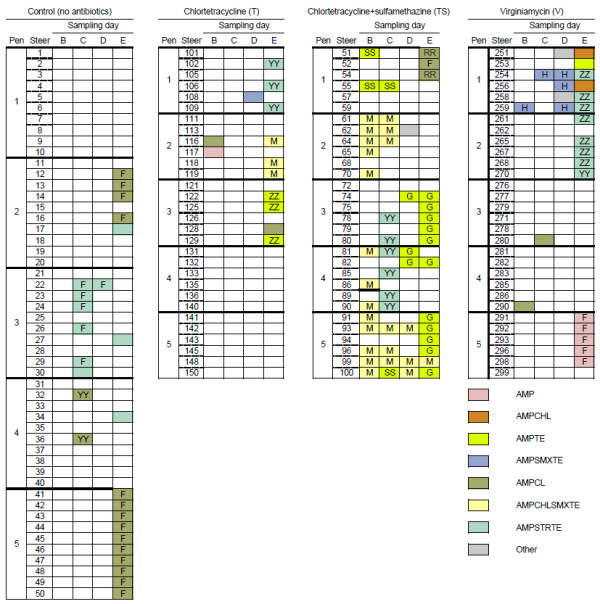
Antibiogram and PFGE types of fecal E. coli isolated from feedlot cattle using MacConkey agar amended with 50 μg/ml ampicillin (MA), as distributed by dietary treatment, sampling day and animal of origin. Sampling days (B to E) are depicted in Figure 1. Each box represents a single isolate from a particular steer on a given sampling day. The first eight colors represent the most commonly observed antibiogram patterns and grey indicates an infrequently observed antibiogram. Unfilled boxes indicate no isolate was obtained on MA. Common letters indicate isolates with >90% genetic homology. Shaded boxes without a letter indicate isolates with <90% genetic homology with antibiogram data. Dietary treatments were as follows: Control: no antibiotics; Chlortetracycline (11 ppm; denoted T); Chlortetracycline + sulfamethazine (44 ppm; denoted TS); and Virginiamycin (31 ppm; V).